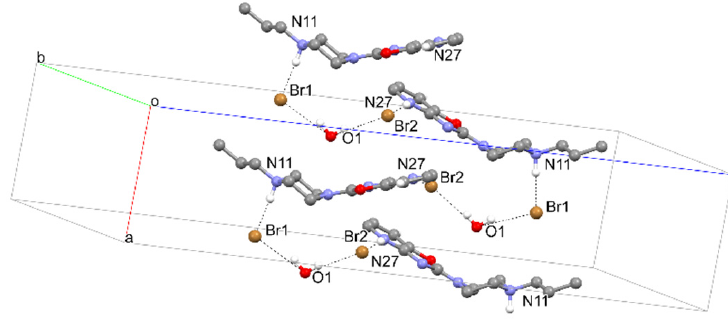
Figure 15. The intermolecular hydrogen bonds in compound 5 . Table 6. Strong hydrogen-bond geometry (Å, º) for 5 .